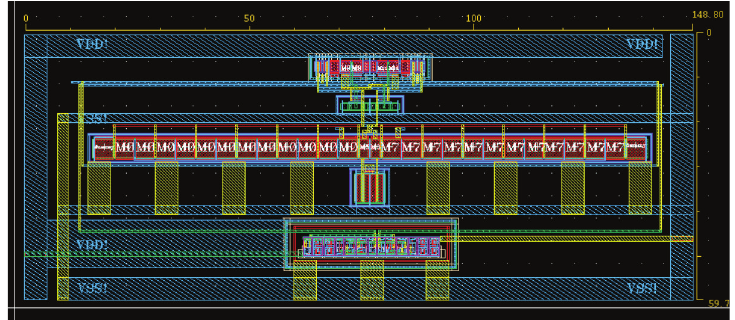
Figure 5: A layout design of the proposed dynamic latch comparator.